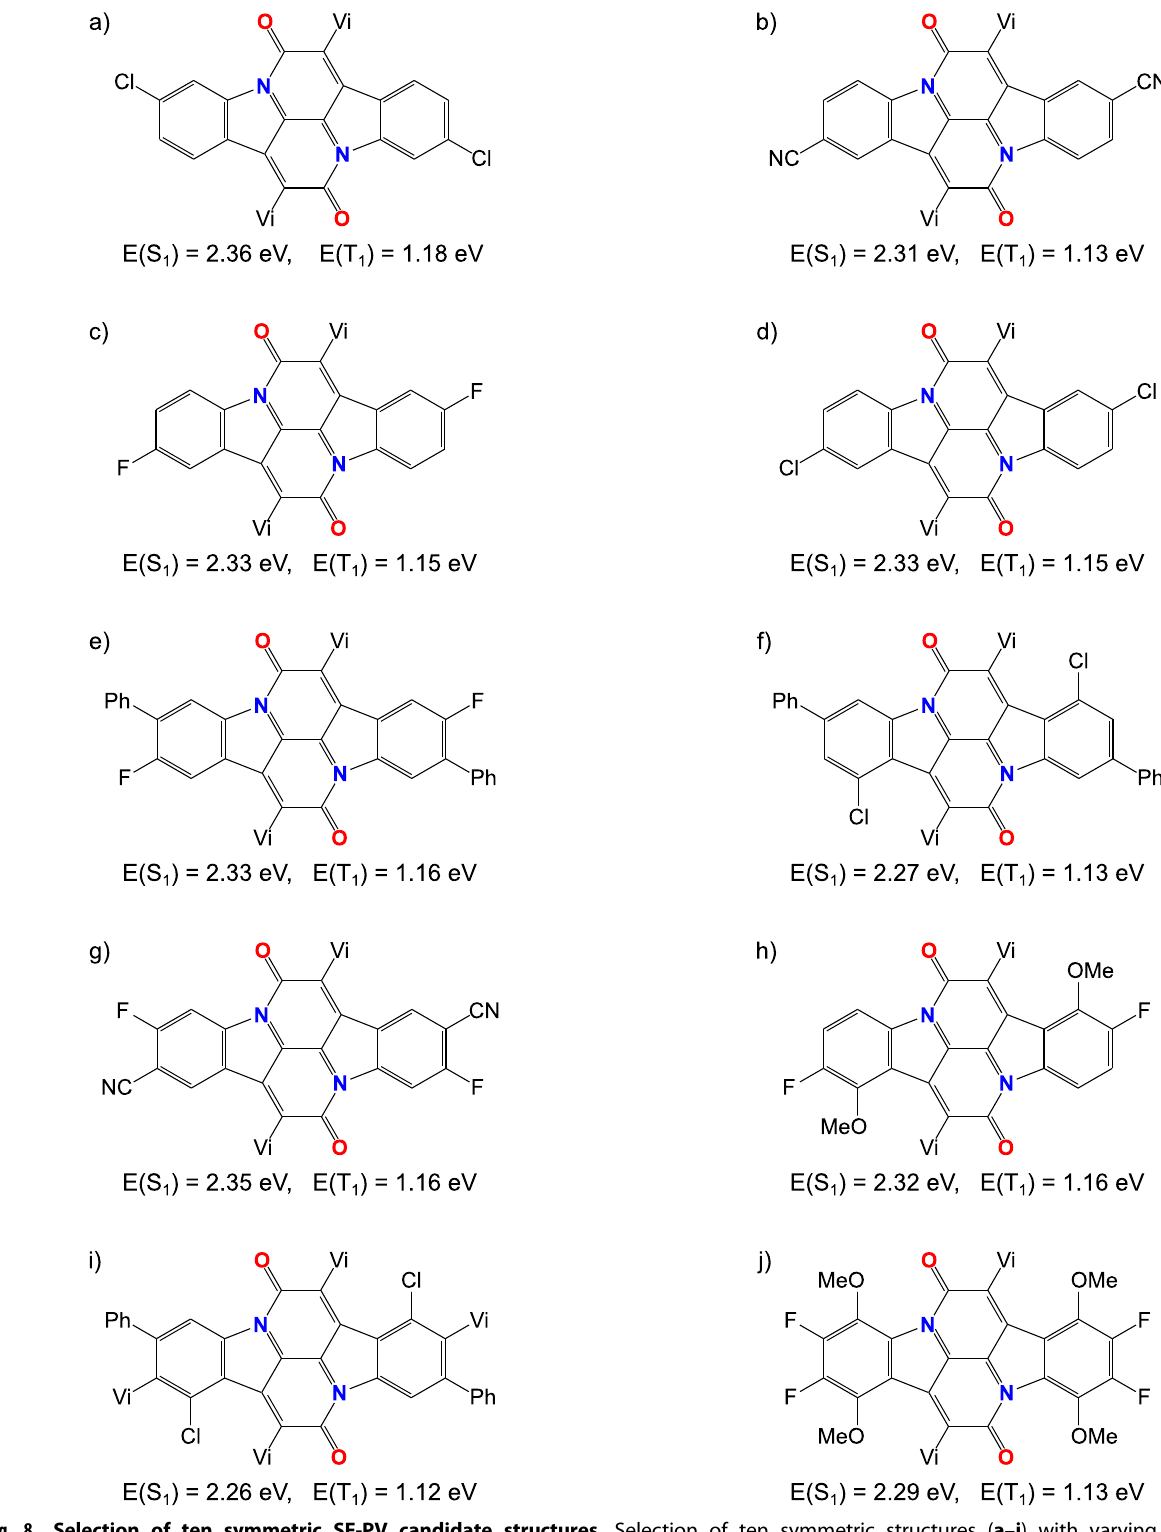
Fig. 8 Selection of ten symmetric SF-PV candidate structures. Selection of ten symmetric structures ( a – j ) with varying degrees of substitution that may be target for synthesis. Excitation energies below the molecules were obtained at TDDFT/ Δ -SCF level of theory. Structural data for these examples are available in the